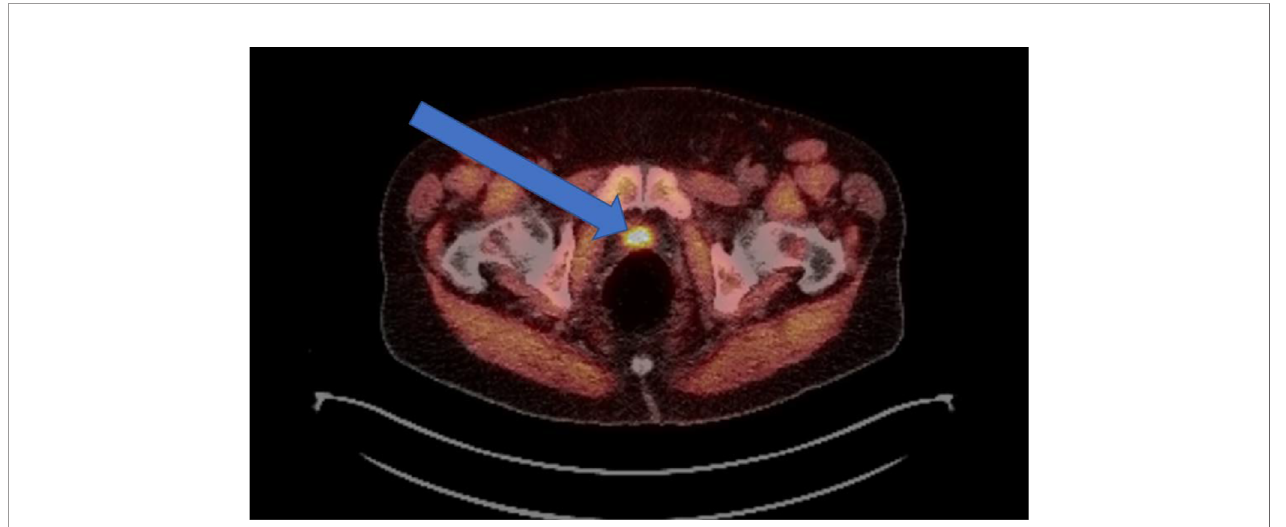
FIGURE 1 | Example of an 18 F- fl uciclovine PET avid lesion in a biochemically recurrent prostate cancer patient. Demonstration of a 2.3-cm 18 F- fl uciclovine PET-avid lesion in the prostatectomy bed. Patient was post-radical prostatectomy and presented with a PSA of 0.84